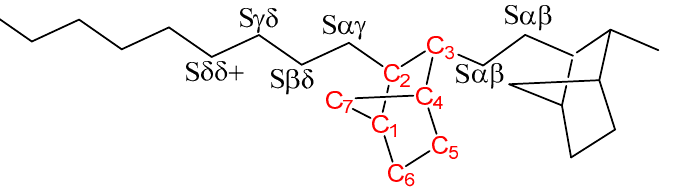
Table 4. Compositional sequences for resultant